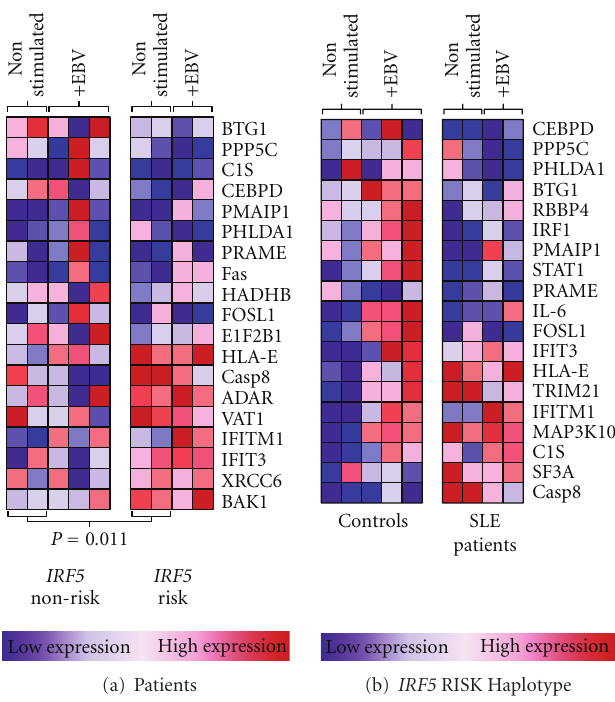
Figure 4: Dependence of the interferon response signature on IRF5 haplotype in SLE patients. Interferon signature genes identified in gene set enrichment analysis were compared between patients and controls, and between lupus patients with the IRF5 risk and nonrisk haplotypes. Each column represents expression of genes of interest in individual subjects. (a) Interferon signature genes of 3 IRF5 nonrisk and 2 IRF5 risk SLE patients. Gene expression comparisons are between IRF5 risk and nonrisk SLE patients, either nonstimulated or EBV infected. (b) Gene set enrichment of 3 control IRF5 risk haplotype individuals and 3 SLE patient IRF5